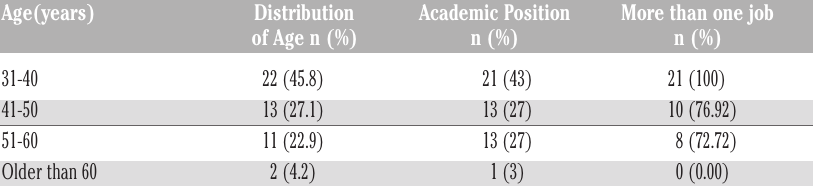
Table 2. Employment characteristics of Peruvian neurologists by age bracket.